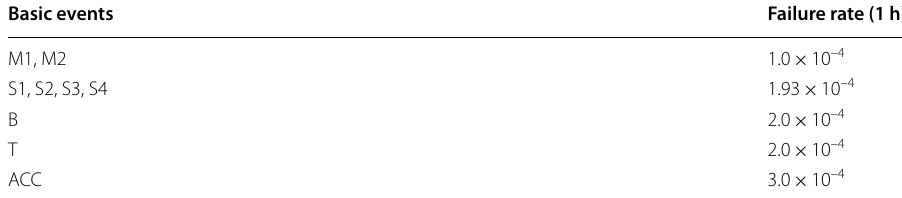
Table 1 Failure rate of the basic events Basic